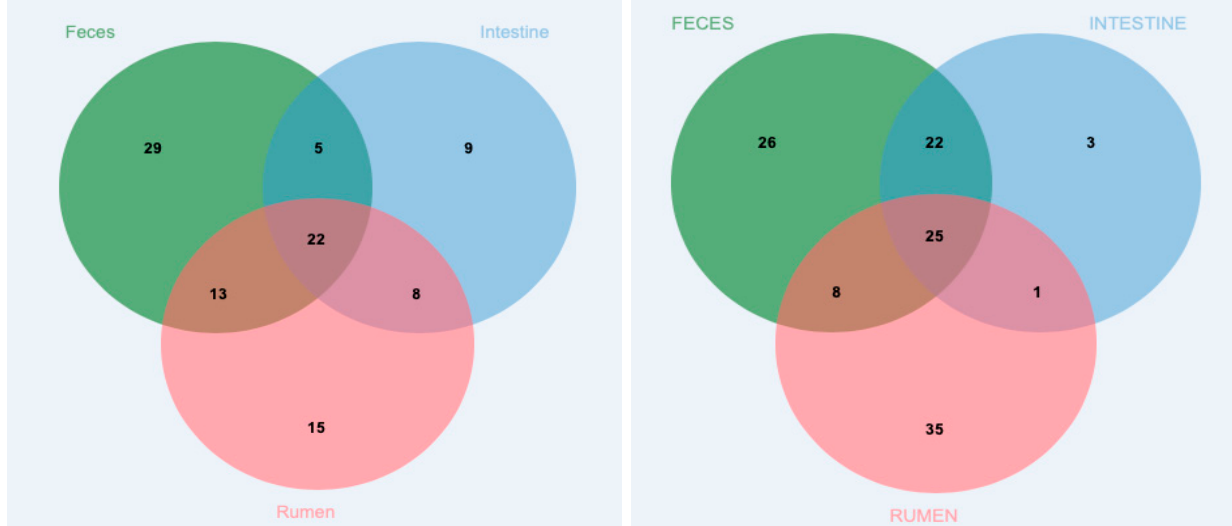
Figure 2. Core microbiota at the Genus level of the rumen, large intestine and feces from differentially fed water buffaloes. Genera shared by at least 80% of samples included in each body site: ( A ) traditionally fed water buffaloes ( n = 10); ( B ) alternatively fed water buffaloes ( n = 10).